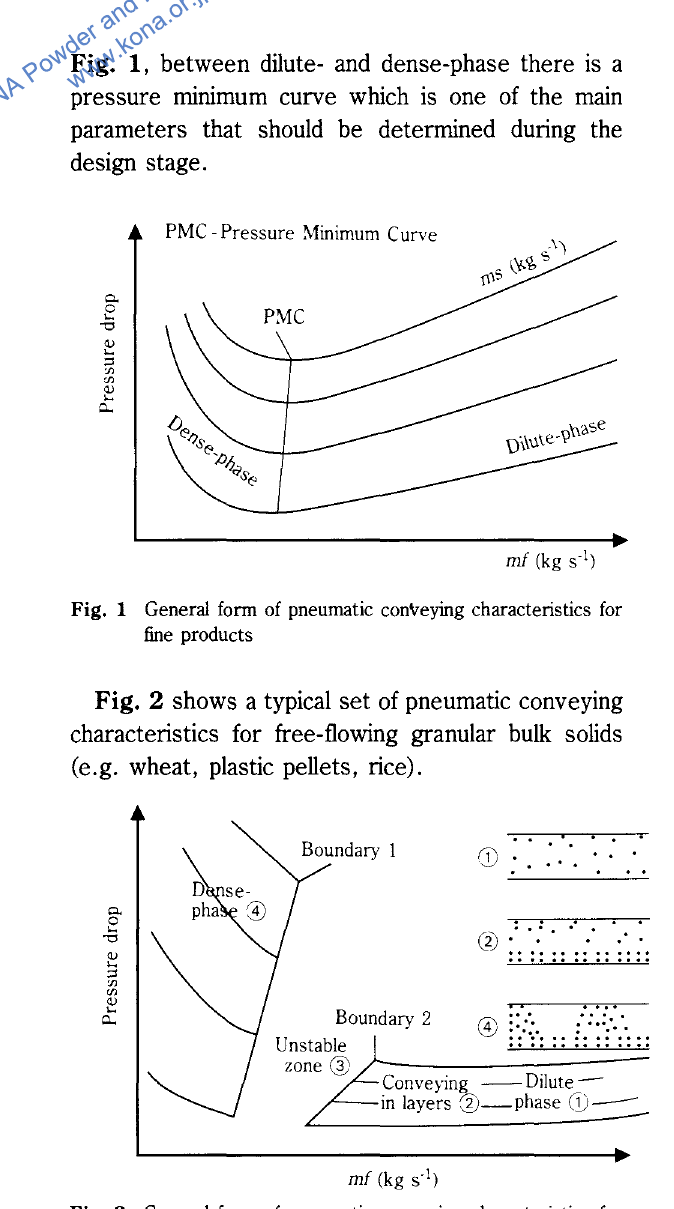
Fig. 2 General form of pneumatic conveying characteristics for granular